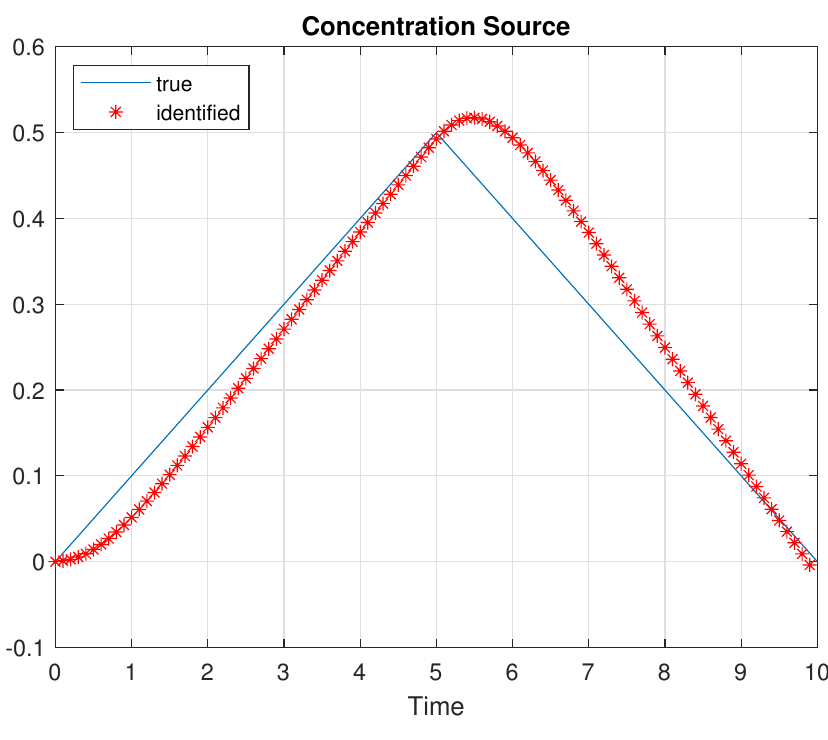
Figure 2. True and recovered values of the concentration source (31).